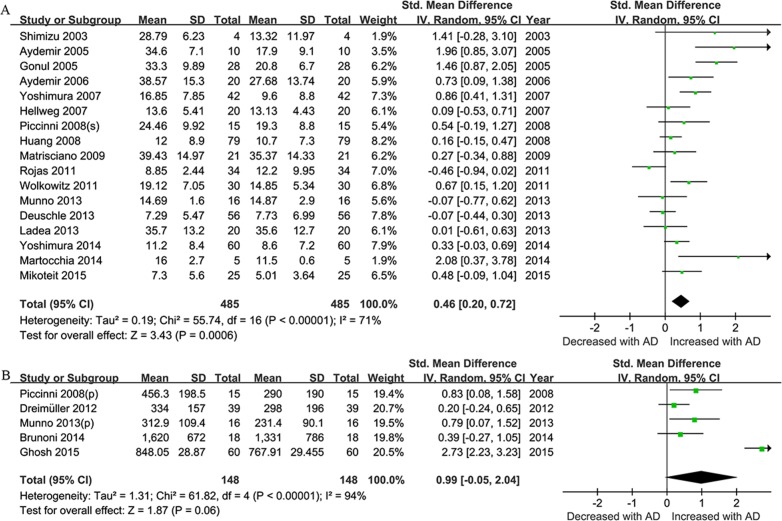
Antidepressants- Stratified Subgroup Meta-Analyses.Forest plots showing the summary effect sizes for levels of BDNF pre- and post- different kind of antidepressant drugs treatment (less than 12 week). (A) using SSRIs;(B) using SNRIs.